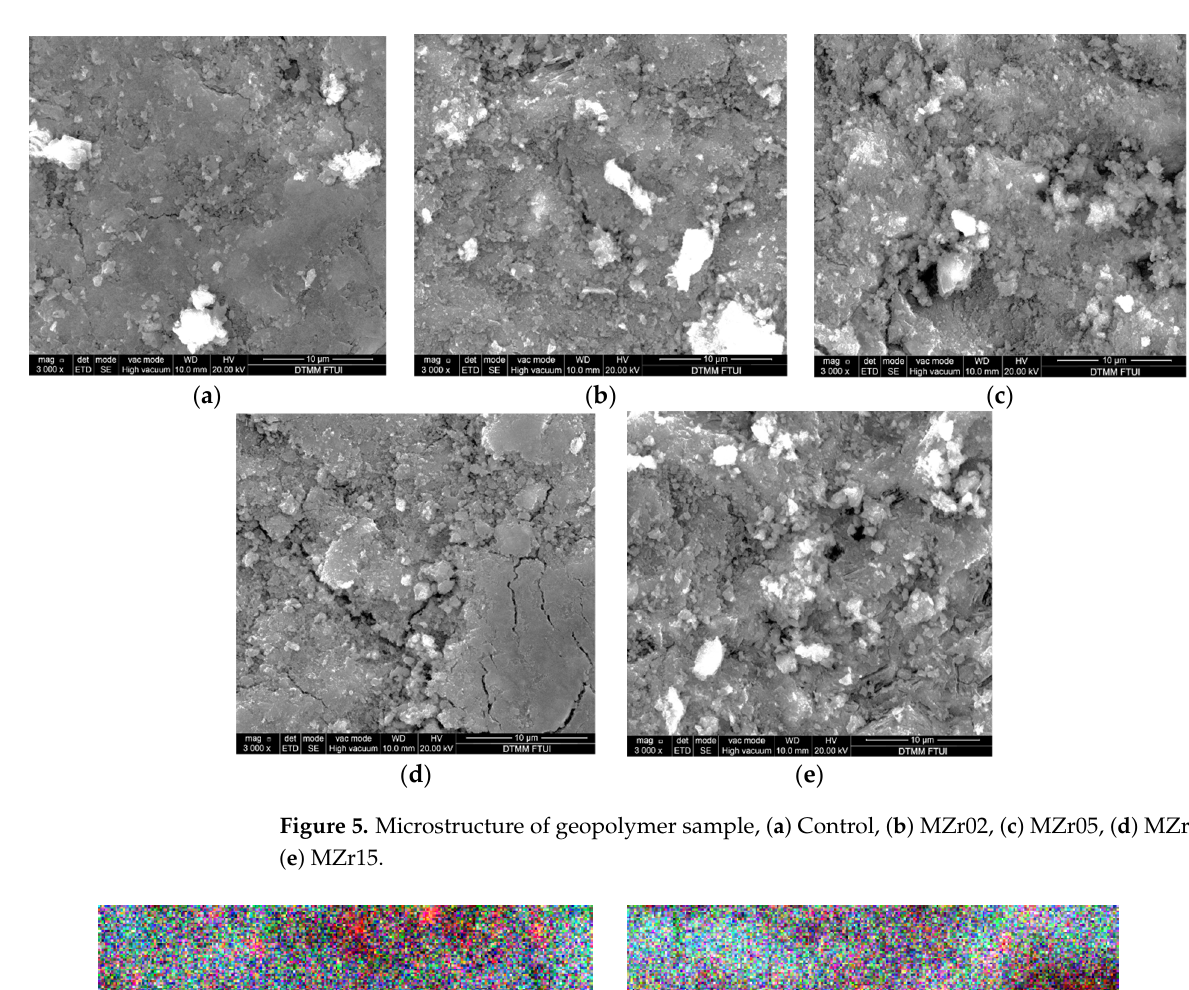
Figure 5. Microstructure of geopolymer sample, ( a ) Control, ( b ) MZr02, ( c ) MZr05, ( d ) MZr10, and ( e ) MZr15.